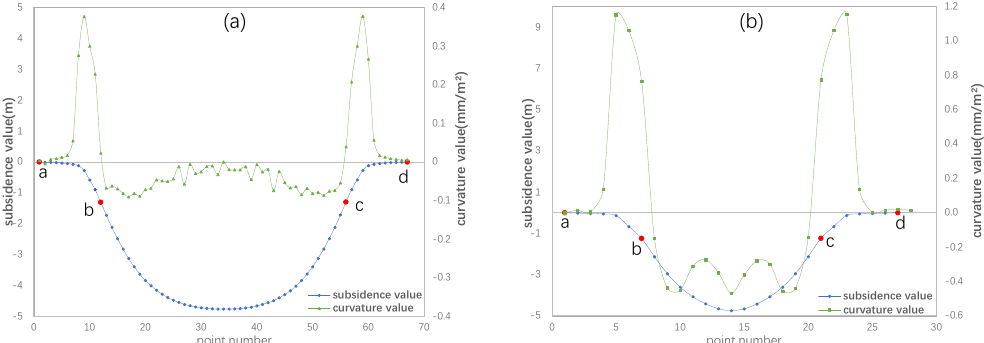
Figure 7. Subsidence and curvature curves in the main section. ( a ) The subsidence and curvature curves in the strike direction; ( b ) the subsidence and curvature curves in the dip direction. The parameters a and d are the boundary points of the basin in the main section; b and c are the inflection points of the basin in the main